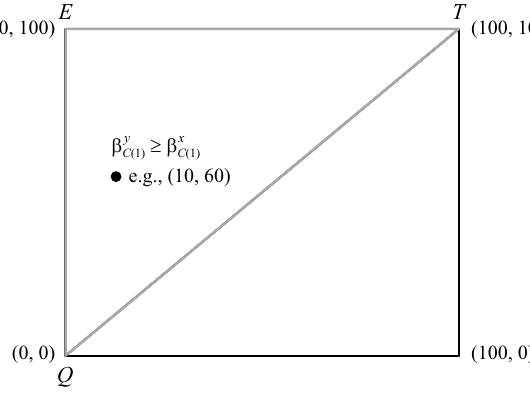
Fig. 3. The consumer’s pre-alliance beliefs about C